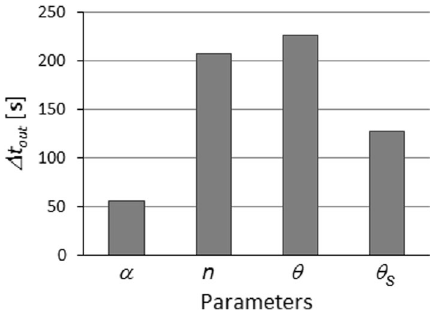
Fig. 2 The differences between the maximum and minimum values of the time of water outflow on the soil surface obtained in the computer simulations of the water pipe failure for the selected parameters